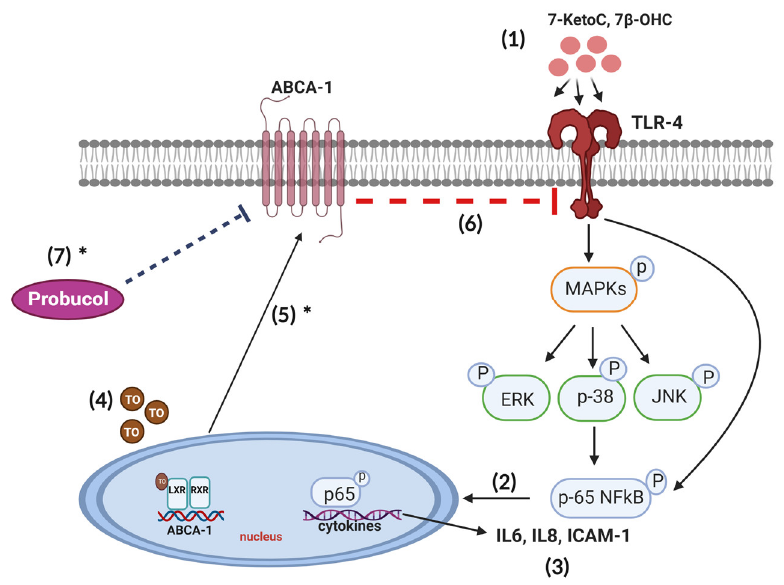
Figure 7. Proposed scheme of ABCA-1 mediated inhibition of TLR-4 activation by oxysterol in human fetoplacental endothelial cells. (1) When fpEC are exposed to 7-ketoC and 7 β -OHC, TLR-4 signaling cascade is activated, with concomitant MAPK (JNK, p38, ERK) and p-65 NF κ B phosphorylation. (2) Upon phosphorylation, p-65 NF κ B complex translocates to the nucleus and (3) initiates transcription of inflammatory mediators such as IL-6, IL-8 and ICAM-1. (4) Treatment with T0901317 activates LXR/RXR heterodimer, which in turn induces ABCA-1 expression and (5) subsequent translocation to the plasma membrane. ABCA-1 initiates membrane cholesterol efflux and alters membrane cholesterol homeostasis [12]. (6) Depletion of cholesterol from lipid rafts of the plasma membrane disrupt TLR-4 activation by oxysterols [20]. (7) Probucol inhibits ABCA-1 mediated cholesterol efflux in fpEC [30], hence favoring oxysterol to activate TLR-4 signaling, while membrane cholesterol is maintained. * already shown in fpEC by others [27,30].